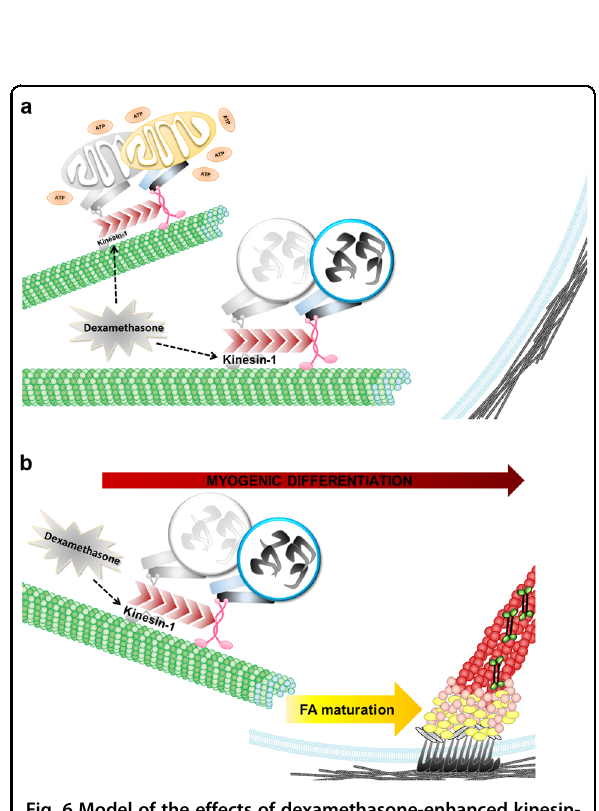
Fig. 6 Model of the effects of dexamethasone-enhanced kinesin- 1 activity on focal adhesion maturation and thence myogenic differentiation. a Upon dexamethasone treatment, the microtubule motor kinesin-1 moves faster, which facilitates mitochondria movement and integrin β 1 translocation to the plasma